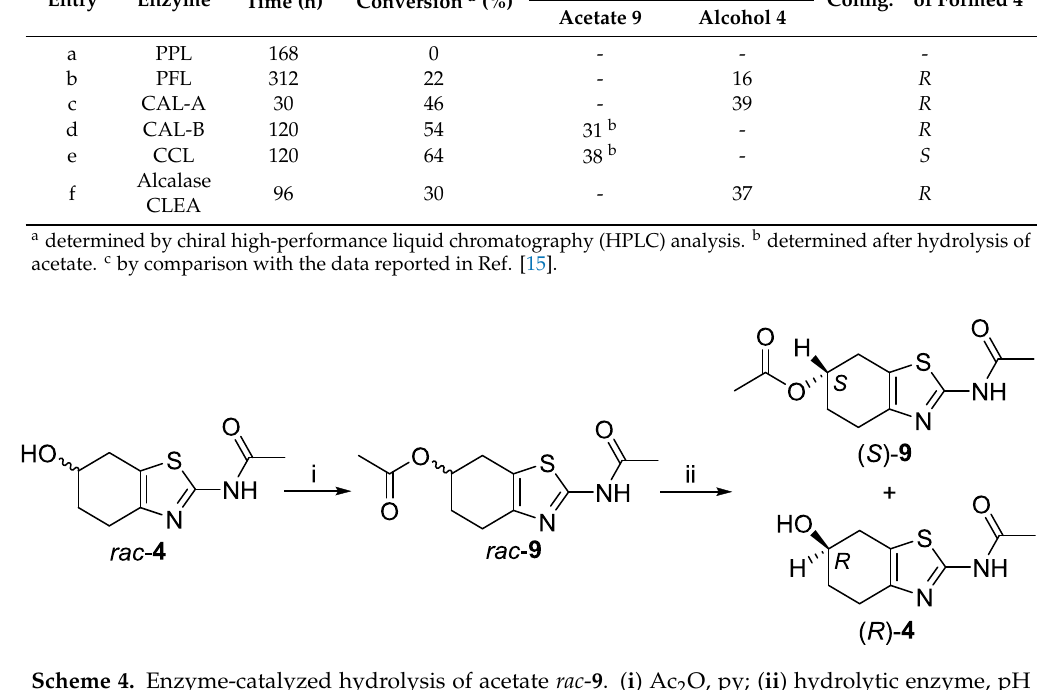
Table 1. Enzyme-catalyzed hydrolysis of acetate rac - 9